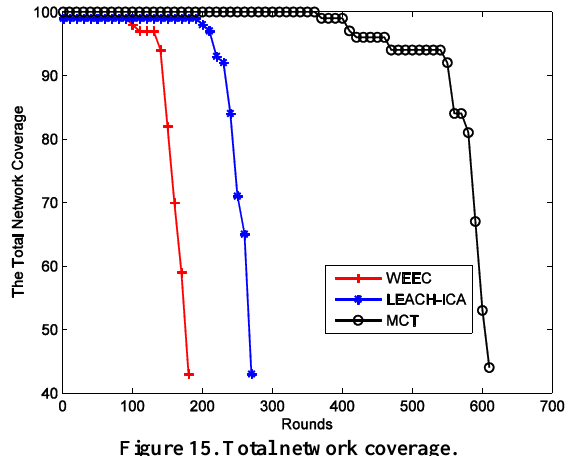
Figure 15. Total network